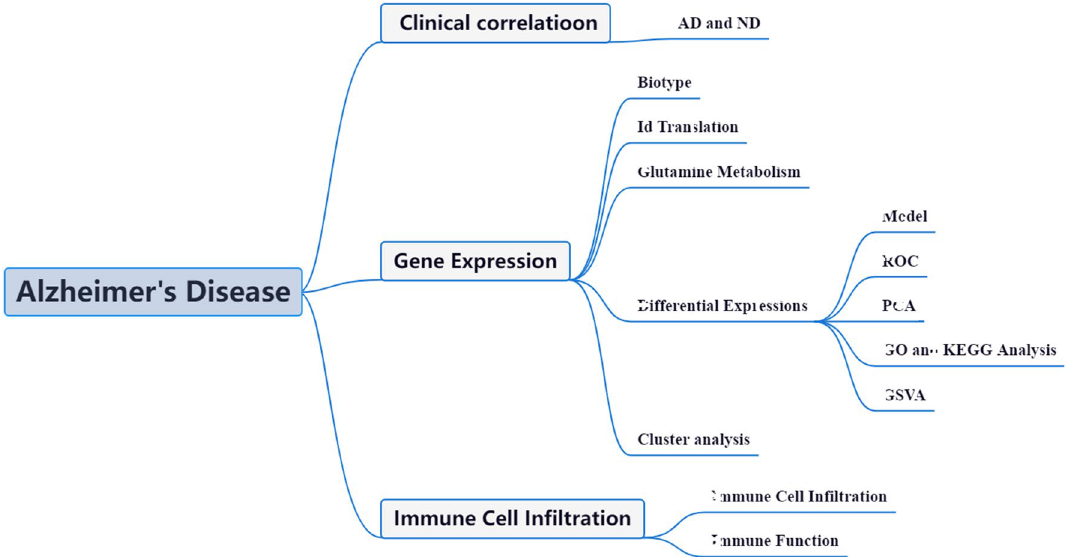
Figure 1. Framework. The data of AD patients were obtained from GEO databases, and then the GlnMgs were matched to carry out difference analysis and risk model construction, respectively.a˘GSE132903 was used as the main body and GSE63060 was used to verify the model with good grouping, and GlnMgs related to the prognosis of AD patients were obtained.a˘Then, GO, KEGG and GSEA analyses were performed with multiple databases to obtain the functions related to GlnMgs.a˘Last, the immune cells, function and RNA changesa˘were analyzed.